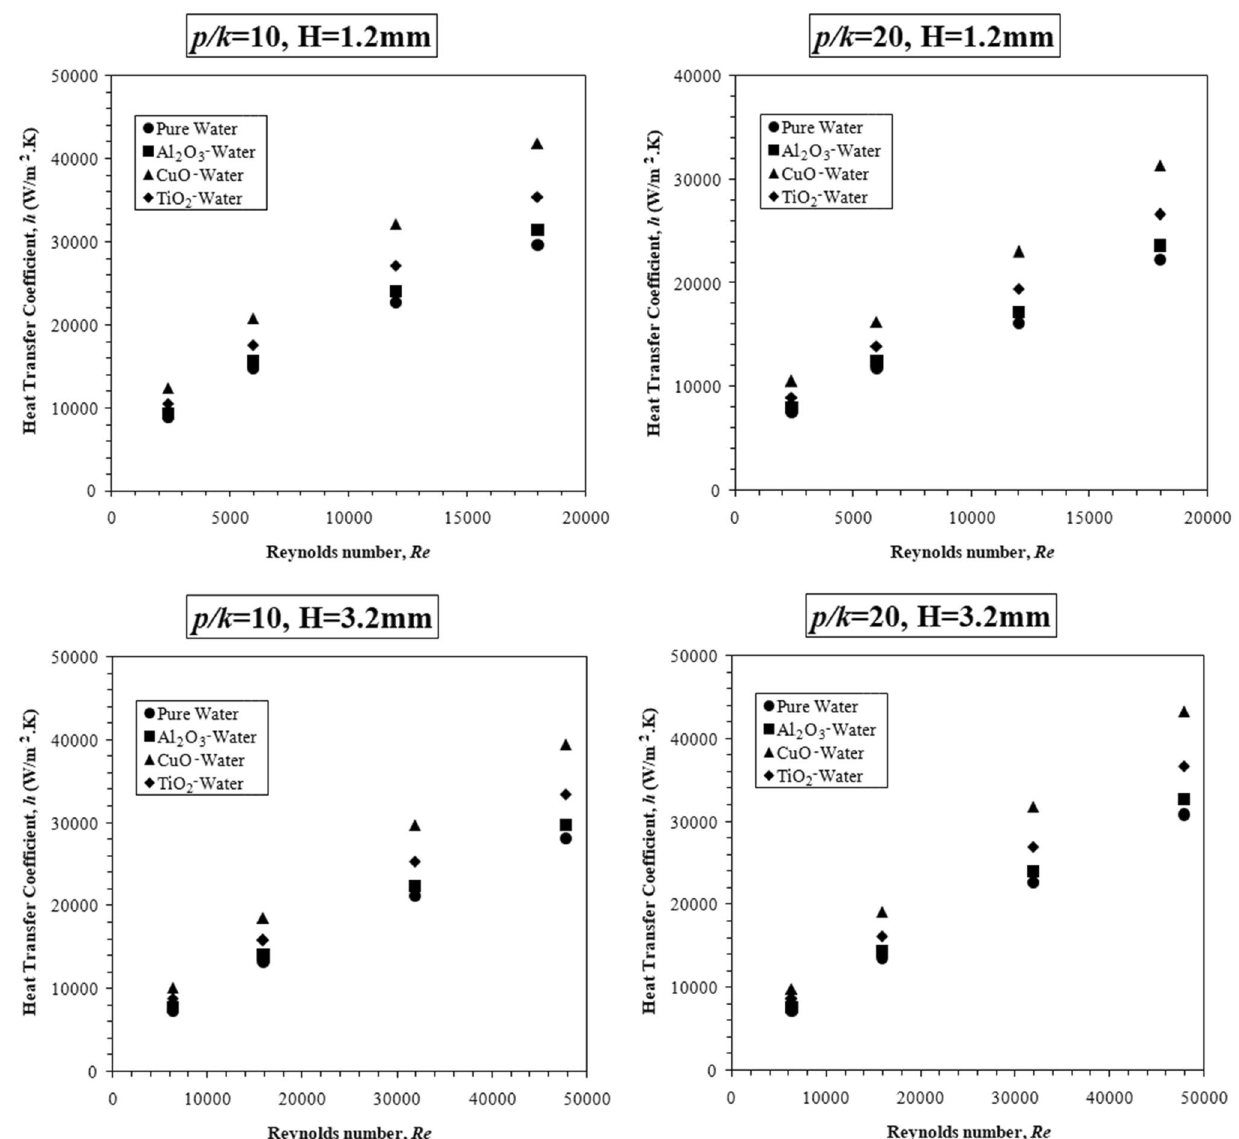
Fig. 16 Comparison of predicted heat transfer coefficients between pure water and t